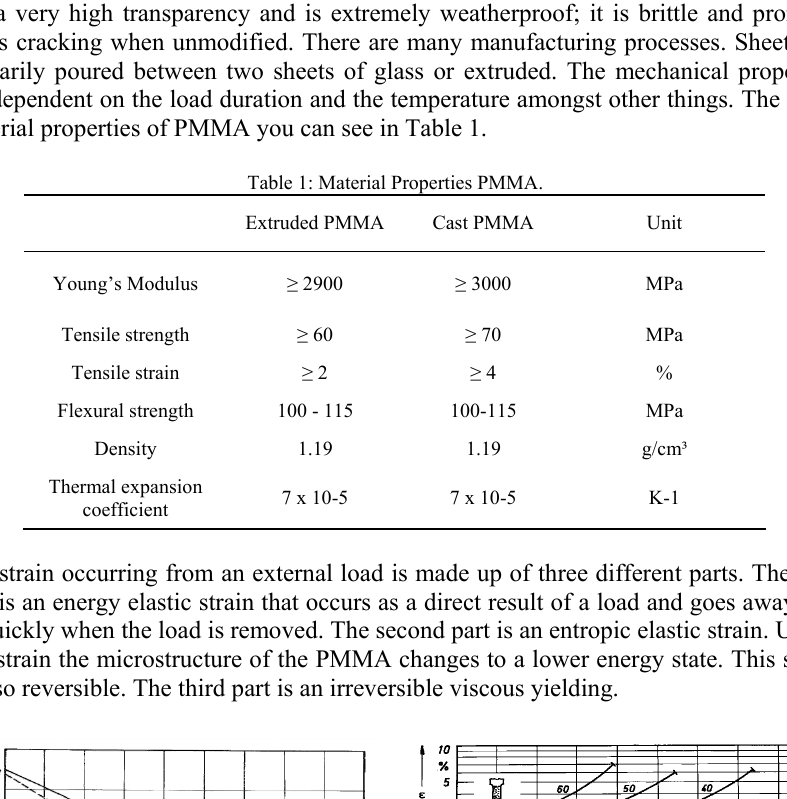
Figure 1: Aquarium with PMMA tunnel.